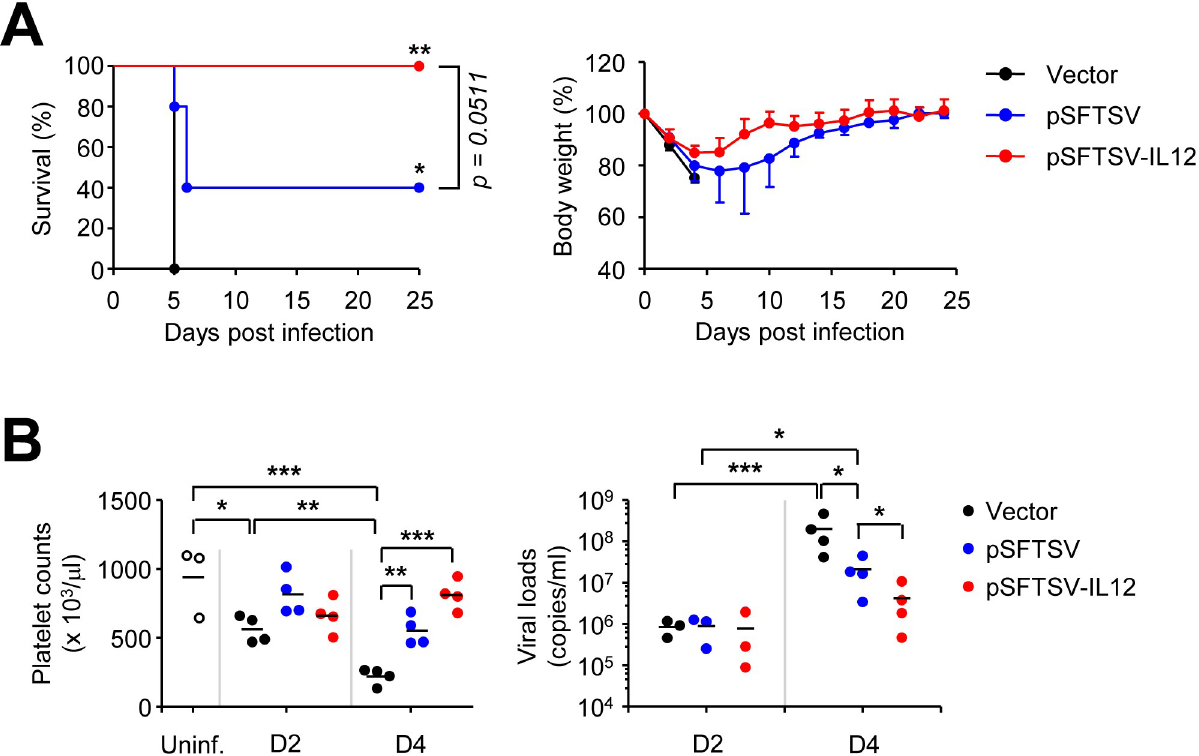
Fig 4. Complete protection of IFNAR KO mice after vaccination with pSFTSV-IL-12. (A) Survival rates (left panel) and body weight changes (right panel) of mice ( n = 5/group) immunized three times with the indicated DNAs and challenged s.c. with 10 5 FFU of SFTSV at two weeks after vaccination. (B) Platelet counts (left panel) and viral loads in plasma (right panel) of mice vaccinated with the indicated DNA vaccines are presented. Blood samples were collected at 2 (D2) and 4 (D4) days after viral challenge. Uninf, uninfected; n = 3 ~ 4 mice/group. � , p < 0.05; �� , p < 0.01; ��� , p <